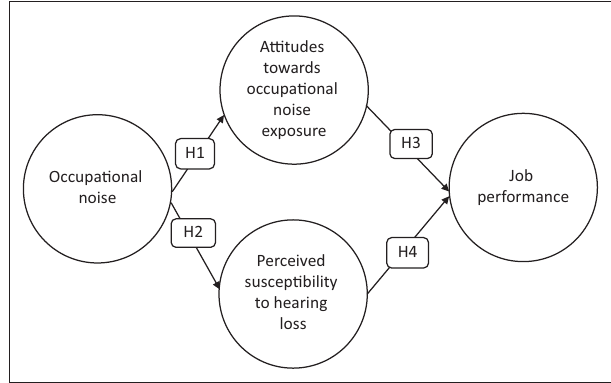
FIGURE 1: Theoretical